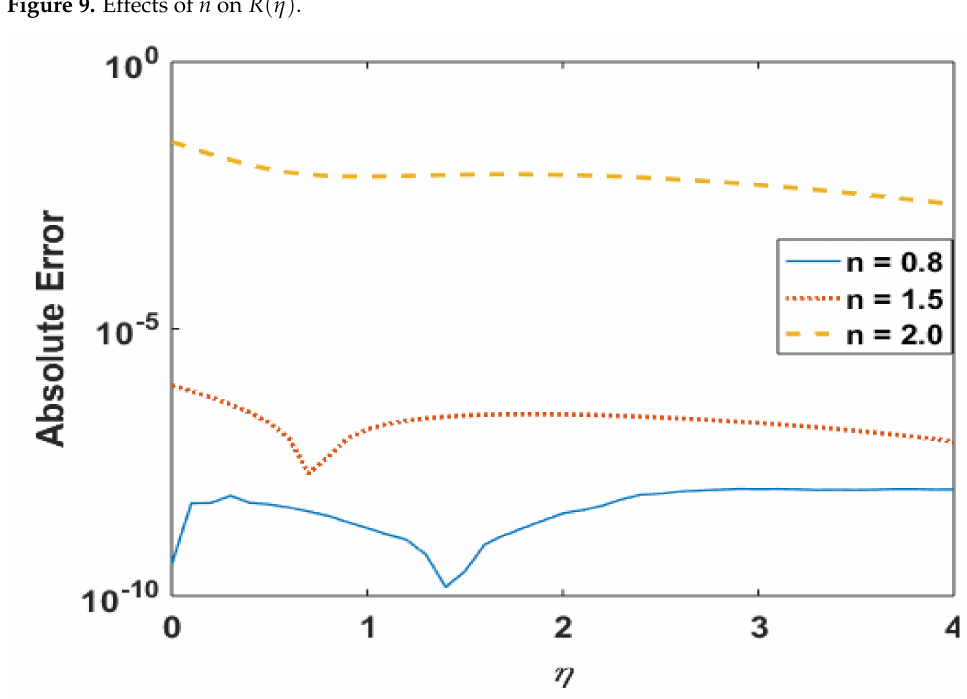
Figure 10. Absolute error in R ( η ) for different